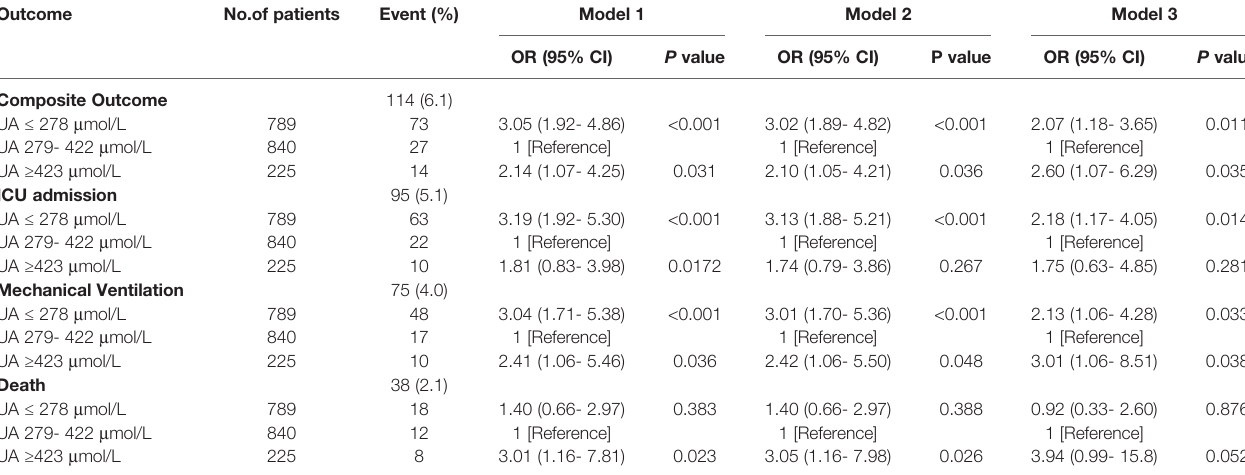
TABLE 2 | Association Between Outcomes and Serum Uric Acid by Categories at Admission.